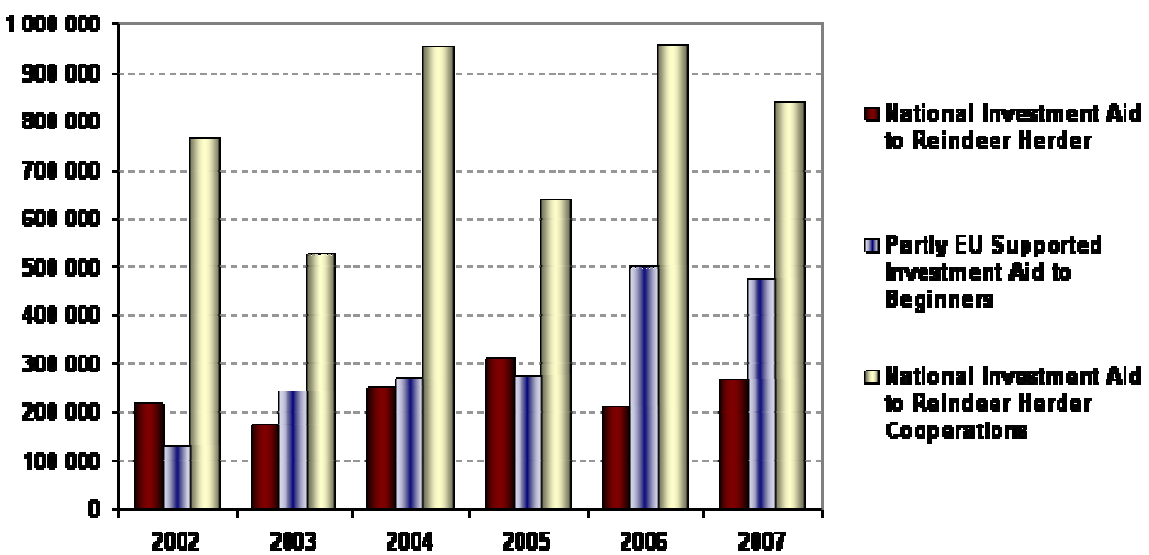
Fig. 3. The amount of investment aids to the reindeer husbandry in 2002- 2007. References: Reindeer herders’ association, Ministry of Agriculture and Forestry, Ministry of Finance, TE- Central in Lapland, European Commission, WTO, World Trade Report